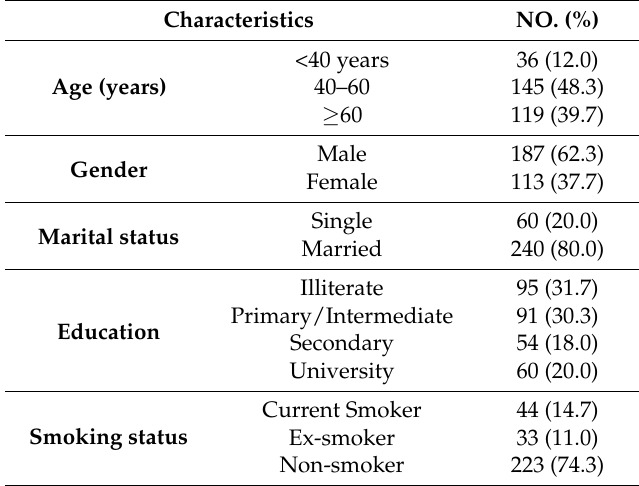
Table 1. Personal characteristics of the study sample of patients attending primary health care centers ( n =